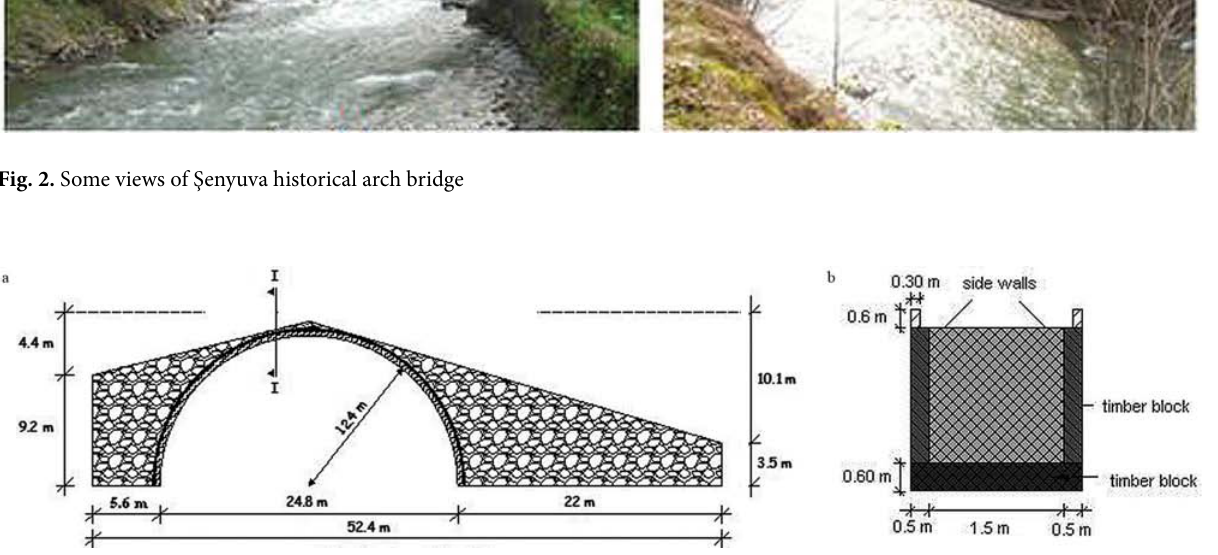
Fig. 3. Section properties of Şenyuva historical arch bridge: a – the plan view of the bridge; b – the section I-I